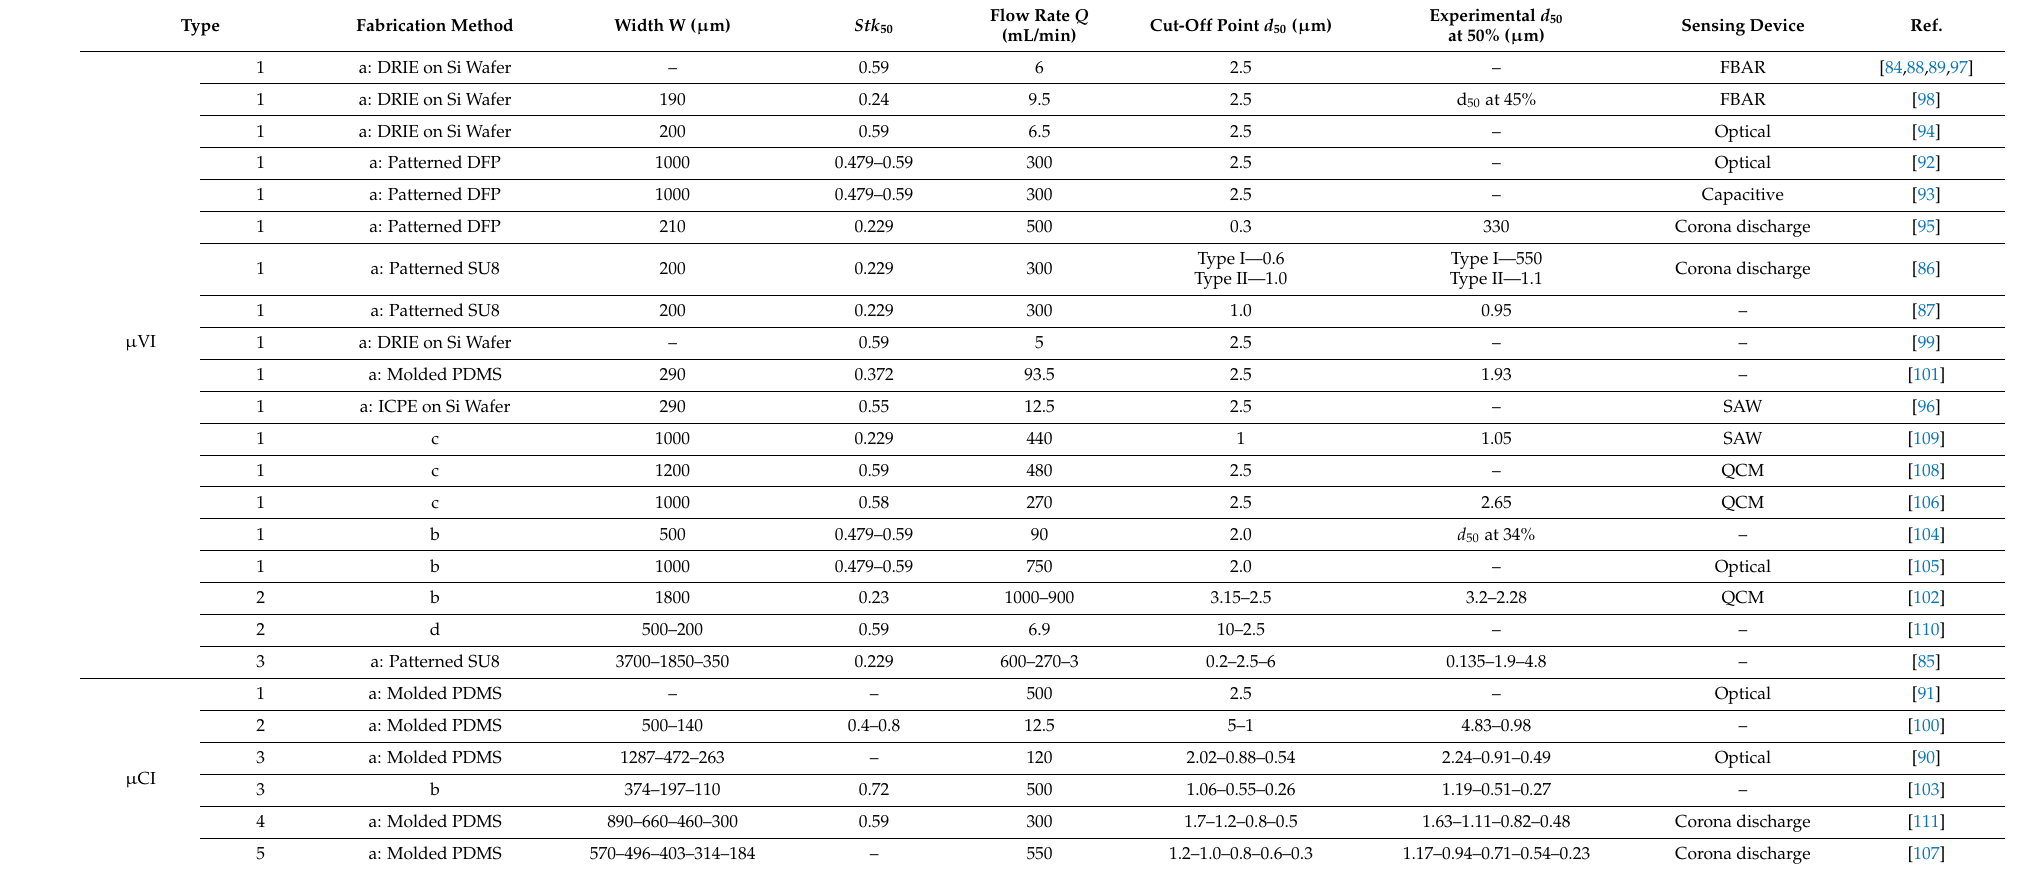
Table A1. Comparison between the key design and performance parameters of µ -impactors found in the